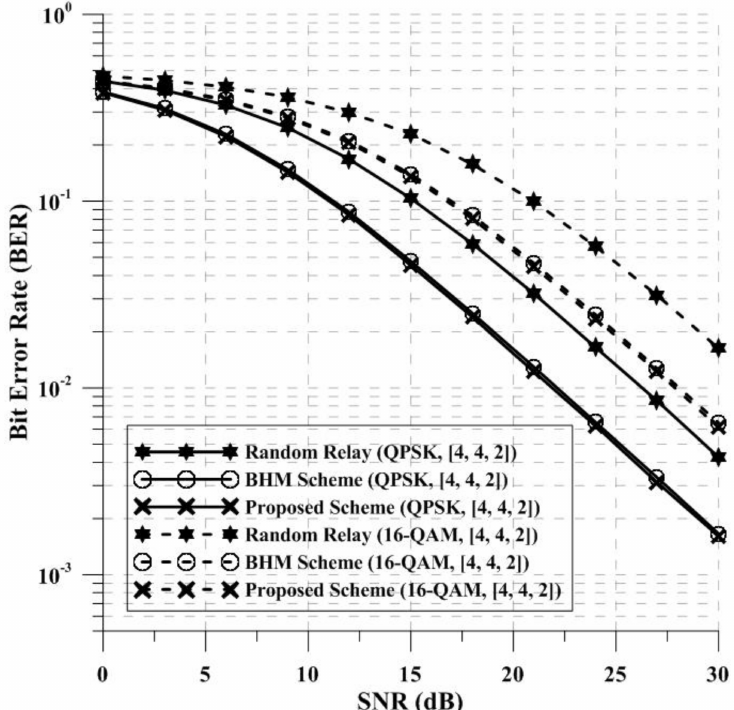
Figure 6. The BER performance of the proposed and conventional schemes in 2D channel environment = 2 ) ( N t = 4, N r = 4, N UE